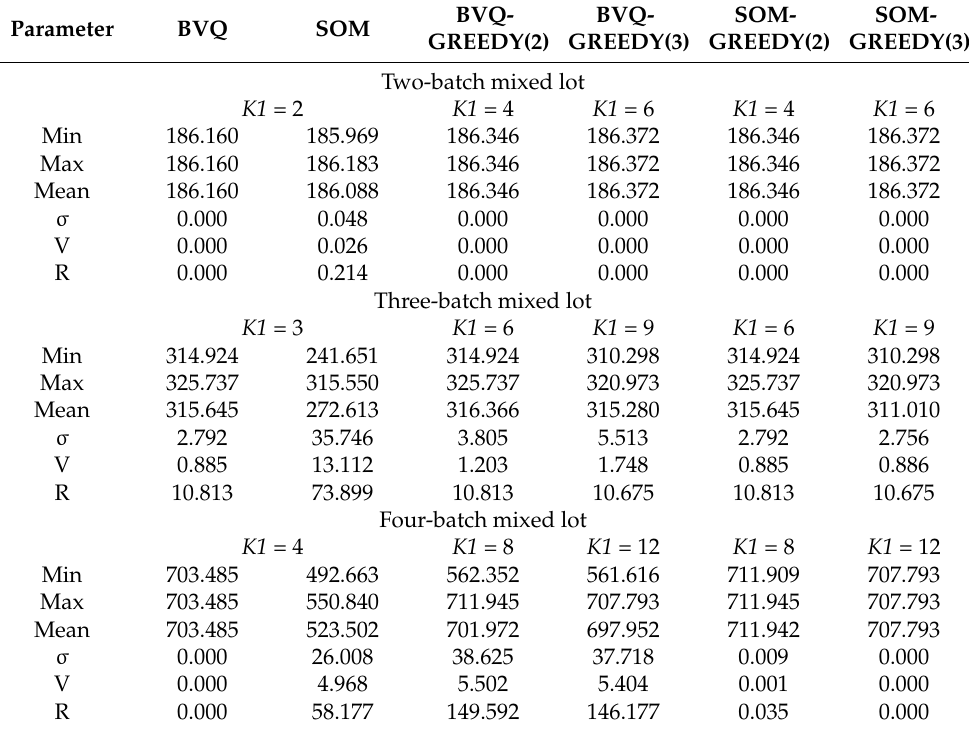
Table A9. Objective function value summarized after 30 attempts (squared Euclidean distance, initialization by random).